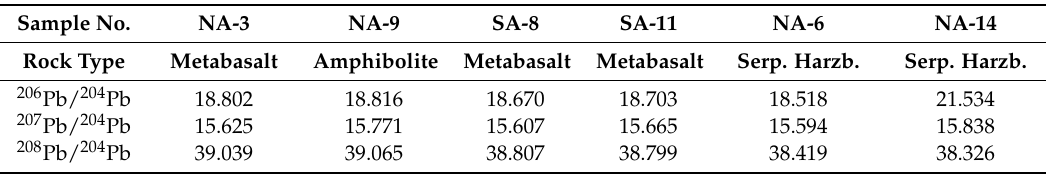
Table 3. Lead isotope compositions of ophiolitic metabasites and associated serpentinites from the Aegean islands (NA—Naxos, SA—Samos).